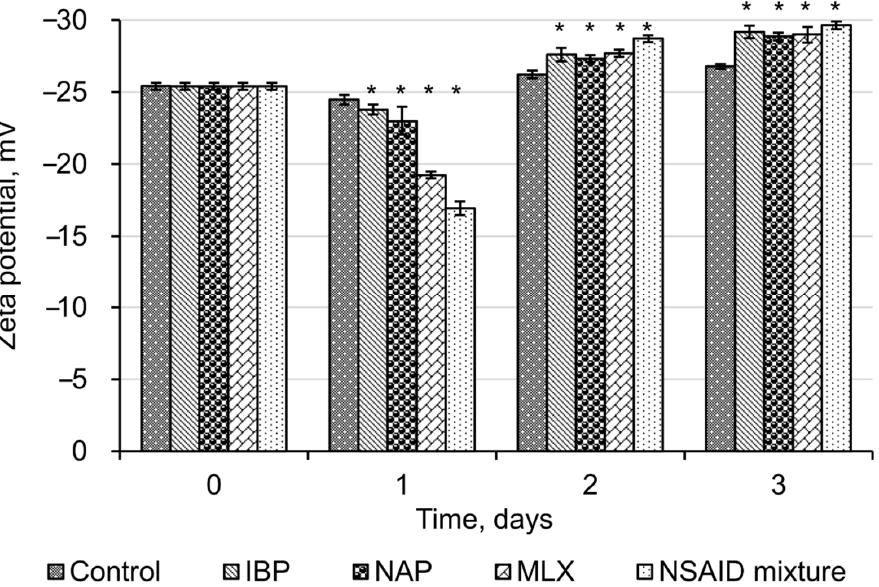
Figure 3. Zeta potential values of R . cerastii IEGM 1278. Cells were grown in the presence of 0.1 g/L glucose (control), 0.1 g/L glucose and selected NSAIDs (ibuprofen, IBP; naproxen, NAP; and meloxicam, MLX), and their mixture. The data are presented as mean values ± standard deviations ( n = 10). Mean values are significantly different from the control: * p < 0.05.